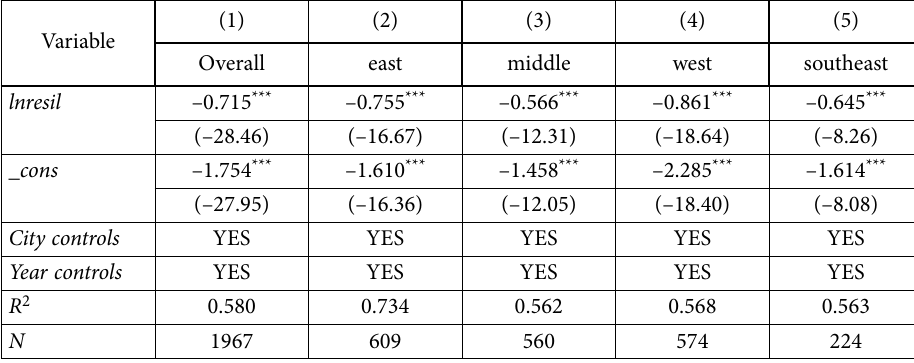
Table 5. The absolute β convergence coefficient estimation of the urban resilience